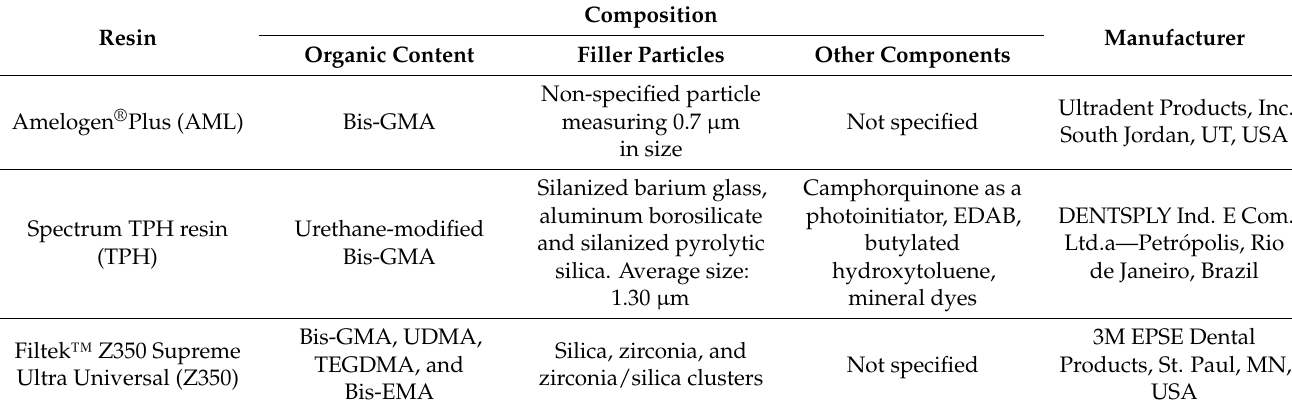
Table 1. Compositions of the composite resins used in this study and their respective technical profiles.